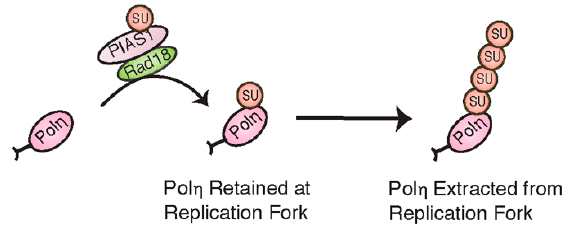
ff ects on Pol η